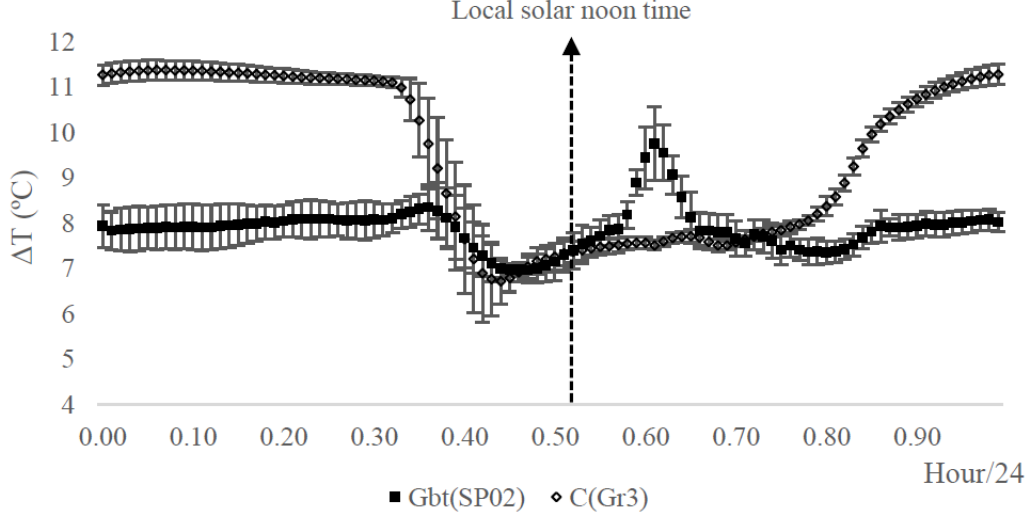
Figure 10. Temperature differences (ΔT, °C) collected with the sap flow sensors in the Adega Catapereiro Vineyard from day 20 to 28 August 2017. Experiment II: the hourly mean (ΔT, °C) with GbtSP02 and CGr3 sensors were clustered on an hourly basis (Hour/24). Full square—Biot-Granier data (ΔT (GbtSP02)). Empty square—conventional Granier data (ΔT (CGr3)).